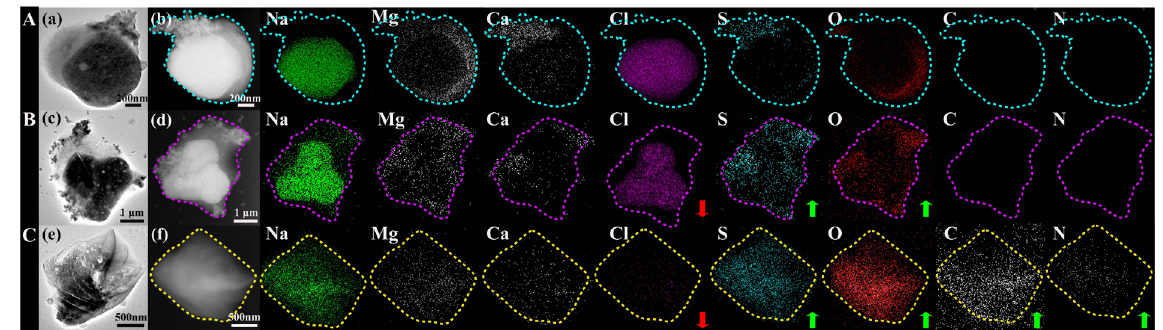
Figure 8. Bright and dark-field TEM images of the fresh, partially aged, and fully aged SSA and elemental mapping of Na, Mg, Ca, Cl, S, O, C, and N. (A) One fresh SSA particle, (B) one partially aged SSA particle, (C) one fully aged SSA particle. The dot intensity represents elemental concentration within an individual particle. The arrows in particles B and C represent increase or decrease in elemental concentration compared to particle